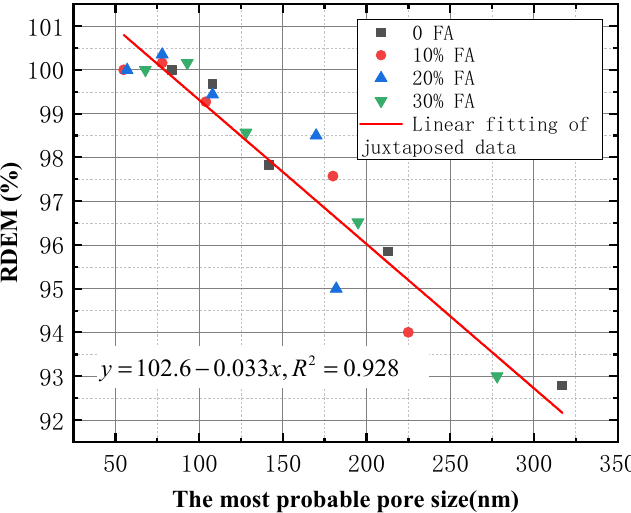
Figure 12. Relationship between RDEM and the most probable pore size.